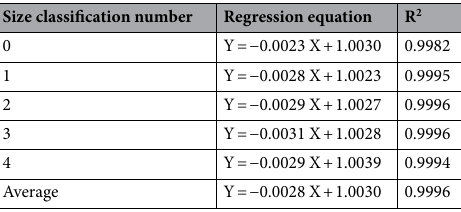
Table 2. Linear regression equation between weight of size classification numbers 0, 1, 2, 3 and 4 with storage time.